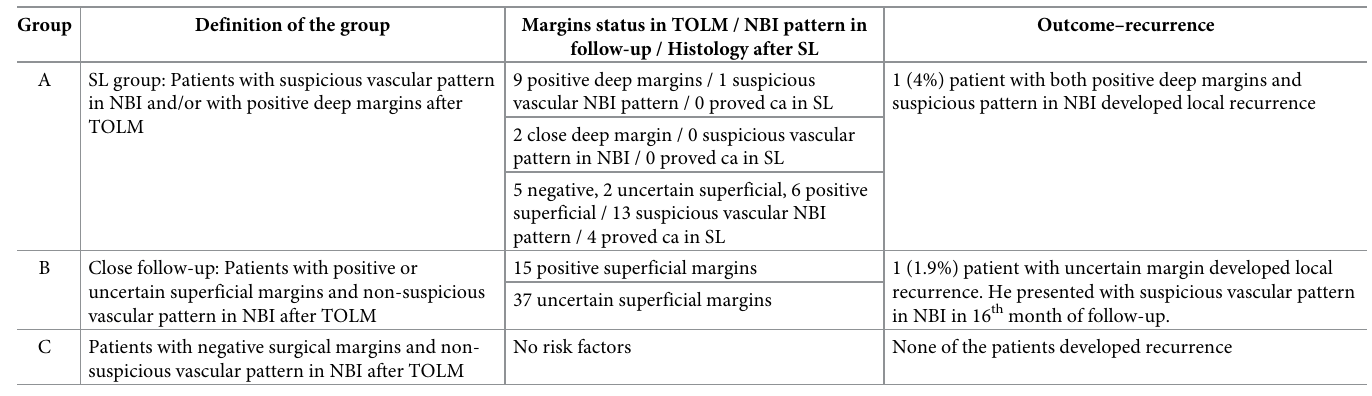
Table 1. Summary of the results.